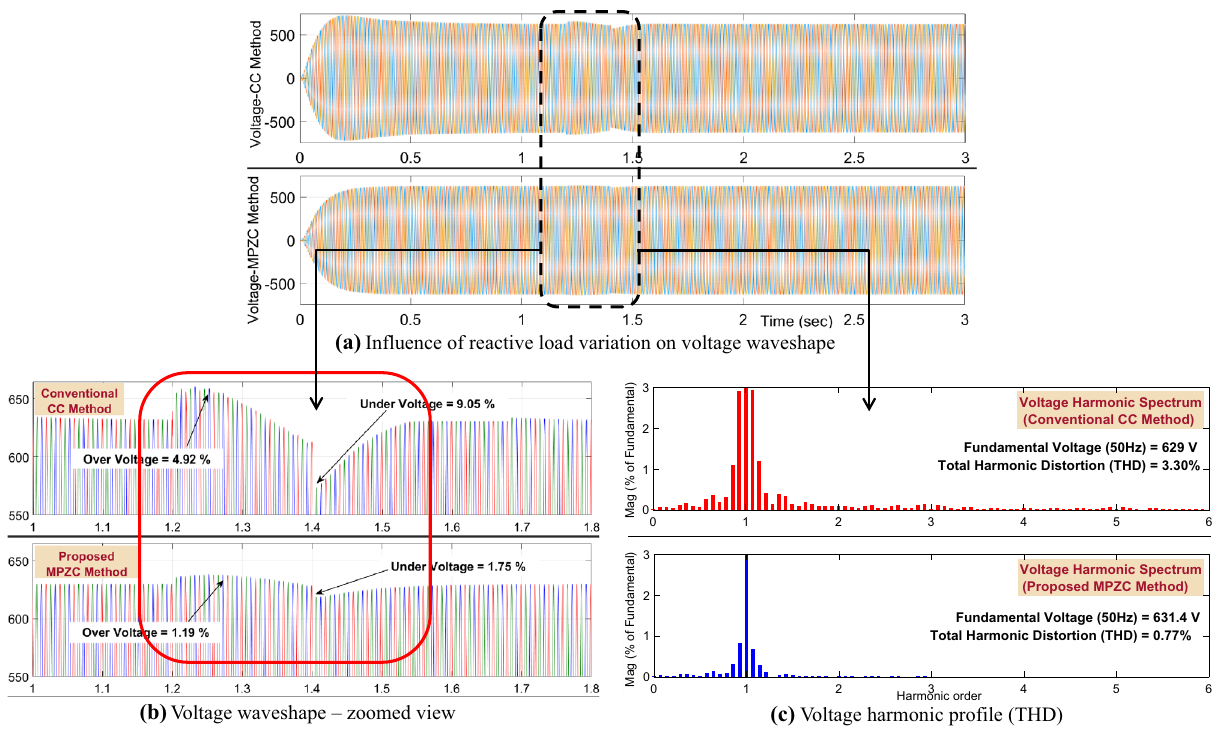
Fig. 15 Impact on 3-Phase voltage profile during disturbance as per test case-T